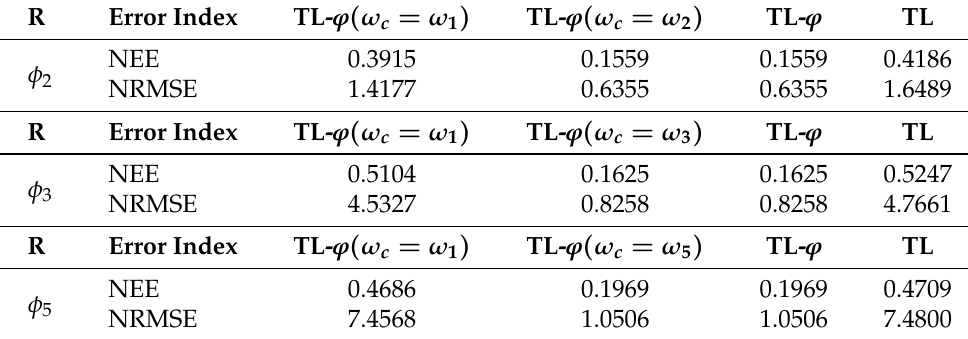
Table 12. Displacement errors of the 5th floor